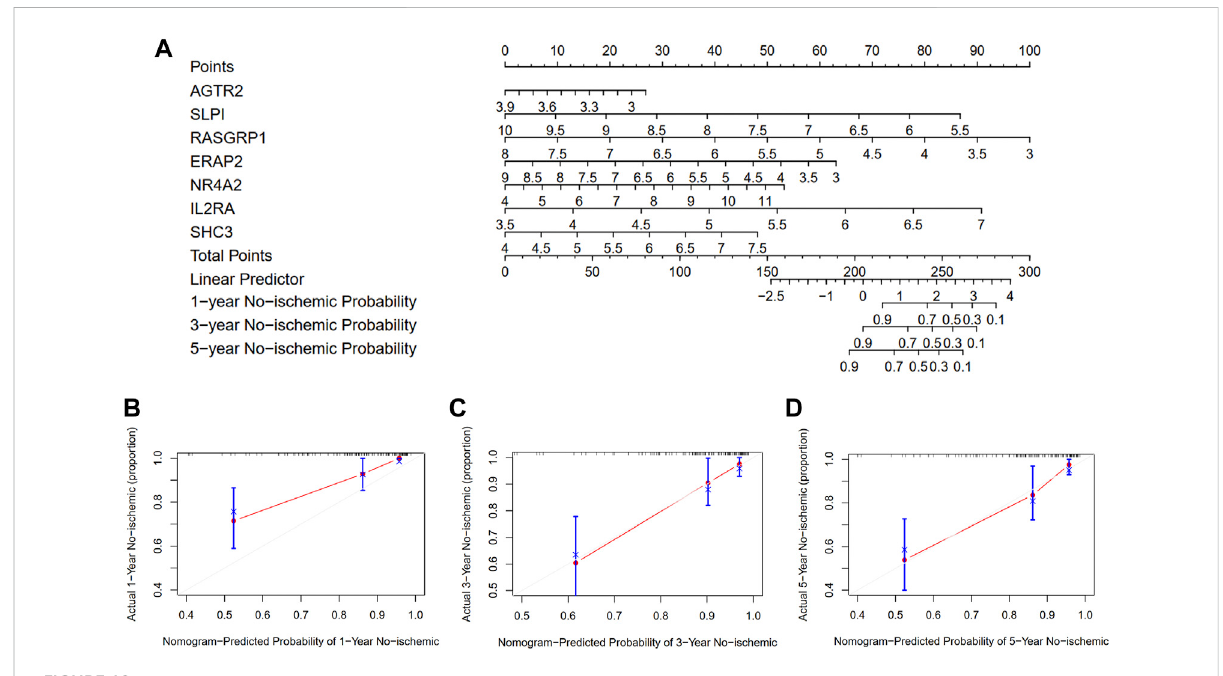
FIGURE 10 Development and evaluation of the nomogram to predict the ischemic event for patients with atherosclerosis undergoing CEA. (A) A combination of seven genes ’ expressions was used to construct a nomogram for predicting the 1-, 3-, and 5-year event-free probability. (B – D) Calibration curves demonstrate that the nomogram-predicted event-free probabilities correspond closely to the observed probabilities for 1-, 3-, and 5-year in patients with atherosclerotic plaque,